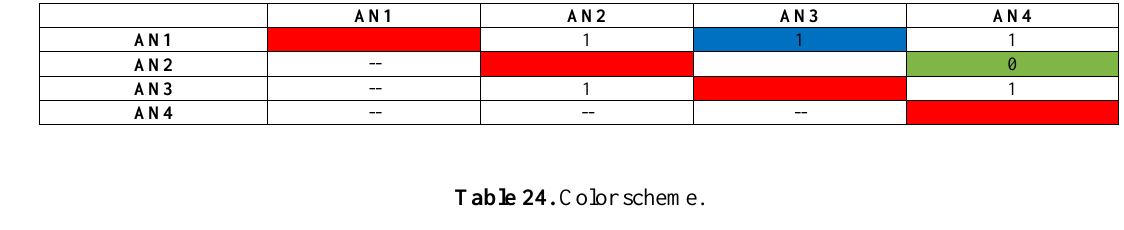
Table 23. Dominating interaction matrix of actions for performance PM3.